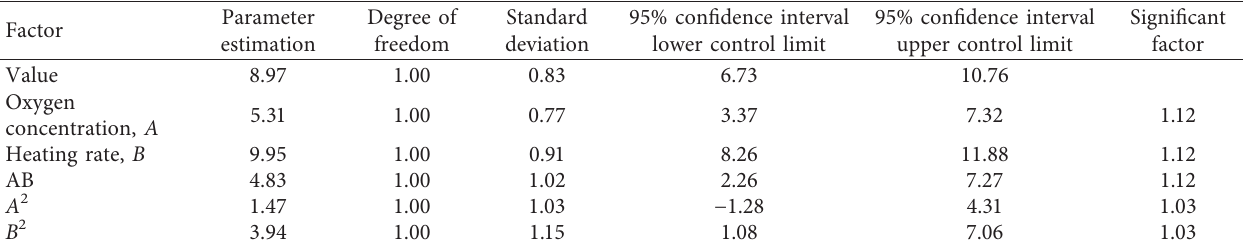
Table 4: The confidence of the two equations for comprehensive combustion characteristic